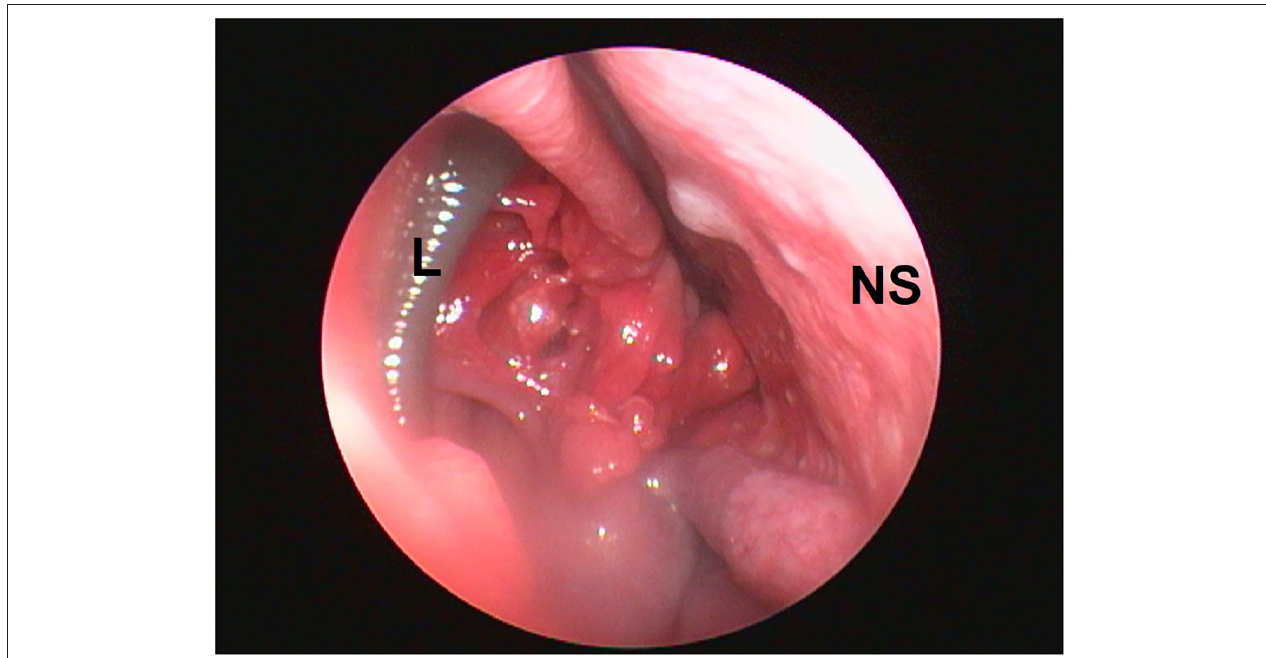
FIGURE 1 | Localization of nasal leech infestation. L, leech; EC, ethmoid conchae; NS, nasal